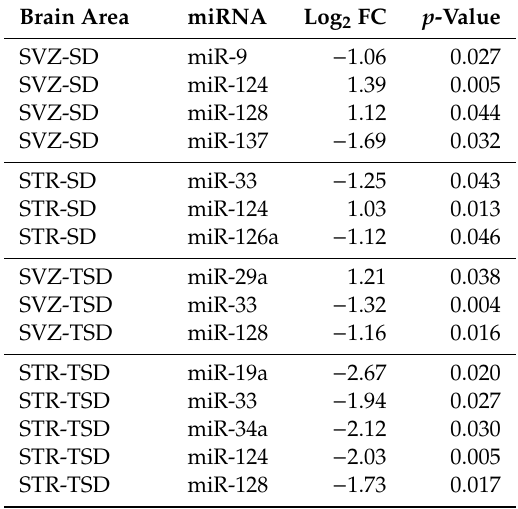
Table 1. miRNAs differentially expressed in SVZ and STR areas from SD and TSD mice. Table 1. miRNAs di ff erentially expressed in SVZ and STR areas from SD and TSD mice. Brain Area Brain